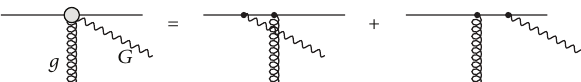
Figure 3: Gauge boson radiation by a projectile quark in the target rest